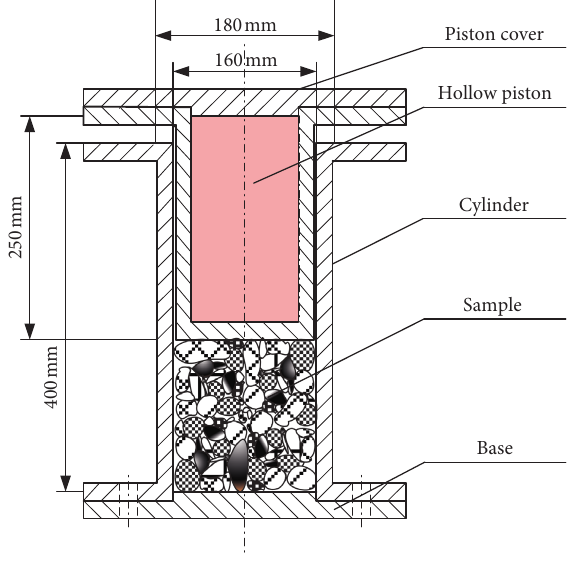
Figure 3: The compaction device.